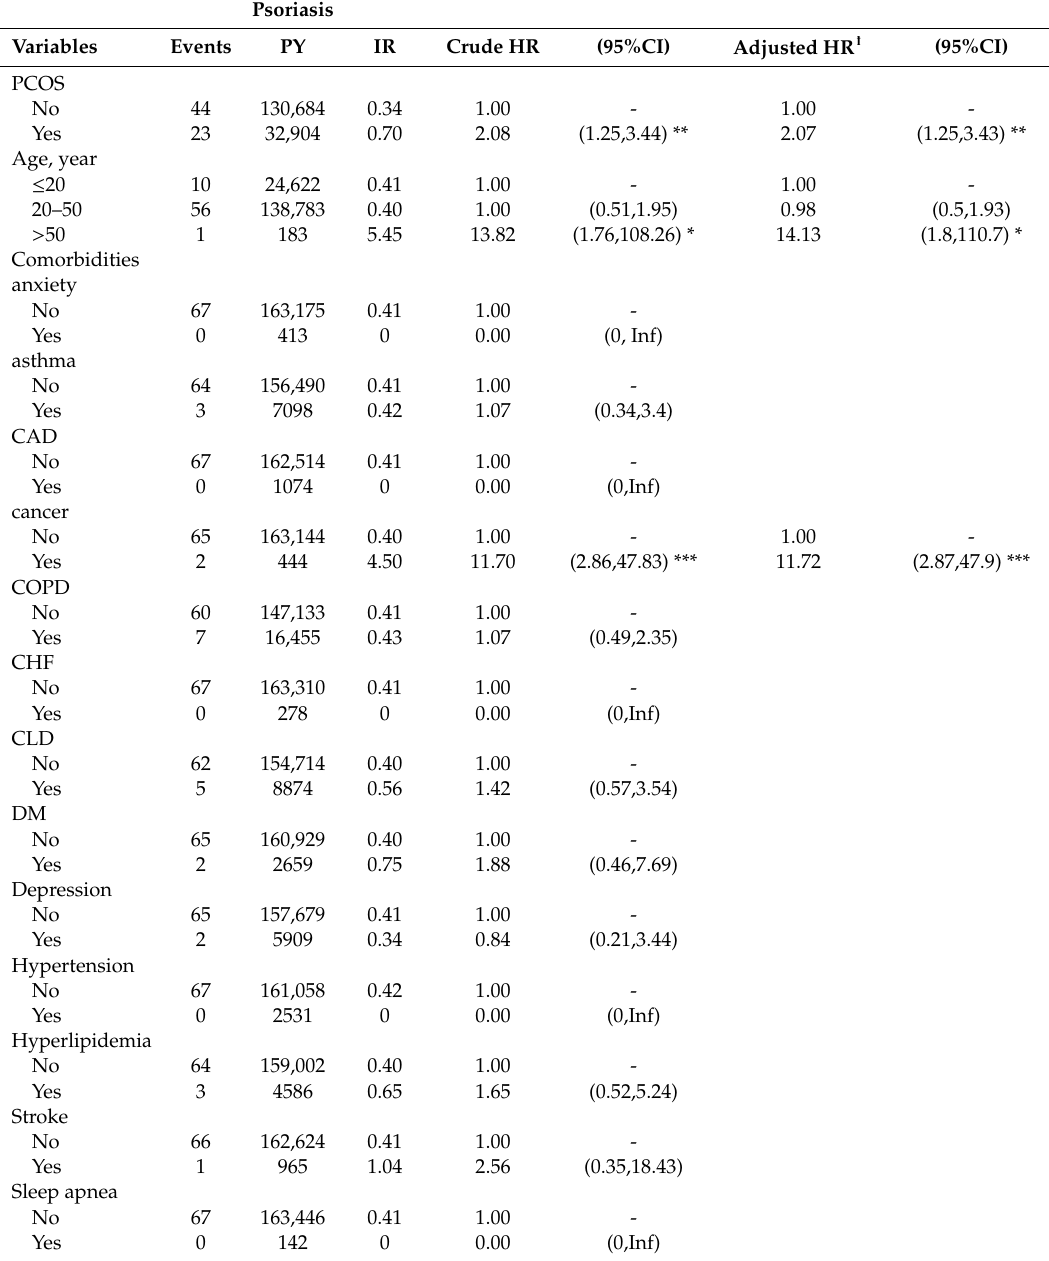
Figure 1. Cumulative incidence of psoriasis for patients with and without PCOS. Table 2. Incidence rates and hazard ratios of psoriasis. Table 2. Incidence rates and hazard ratios of psoriasis.